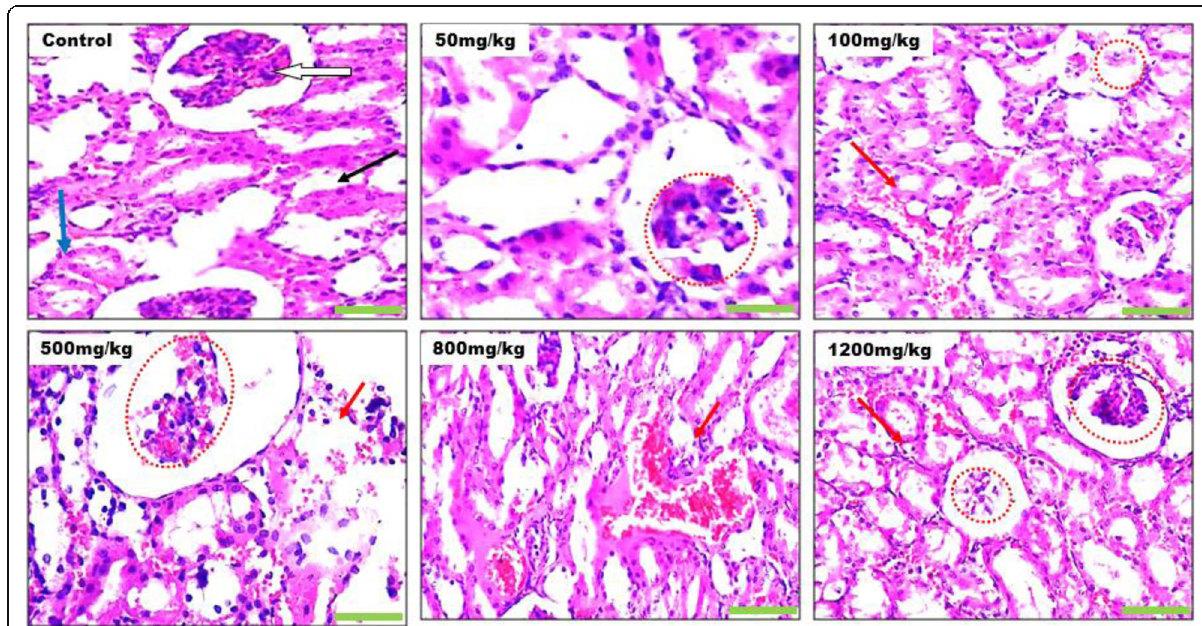
Fig. 2 Photomicrographs of kidney sections stained with Haematoxylin and Eosin (Mag. × 400). Control treated group showed normal micromorphological sections. The renal cortex showed normal glomeruli with mesangial cells and capsular spaces appeared normal (white arrow), the renal tubules appear normal (blue arrow) and interstitial spaces also observed normal (black arrow). No observable focal sclerosis of renal glomeruli, capsular spaces around the glomerulus appears normal with distinct layering of renal microcellular structures. 50 mg/kg-1200 mg/ kg treatment relative to control treatment showed varied degree of renal injury that is dose dependent. In these groups, from mild to severe order; the renal cortex appears distorted, Renal glomeruli and dillated capsular spaces appeared collapsed with characteristic pyknosis of the mesangial cells, The renal tubules, interstitial spaces, appears distorted with presence of red inflammatory cells, hemorrhagic cells infiltrating the renal interstitial spaces as well as focal sclerosis of renal glomeruli with associated degeration of the glomerular membrane (red